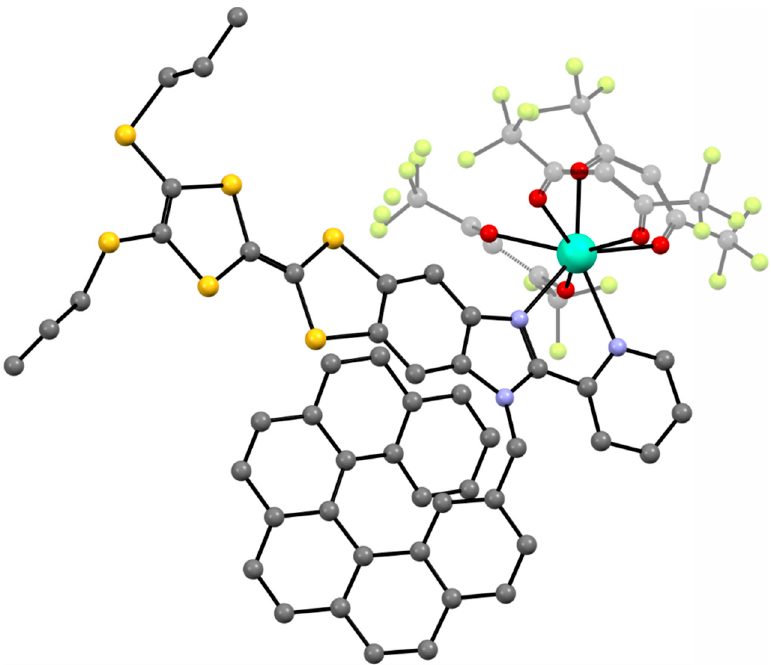
Figure 5. The crystal structure of [Dy(hfac) 3 (L3)] ( 9 ). Dy—teal, O—red, C—gray, N—blue, F—bright yellow, S—yellow. yellow,